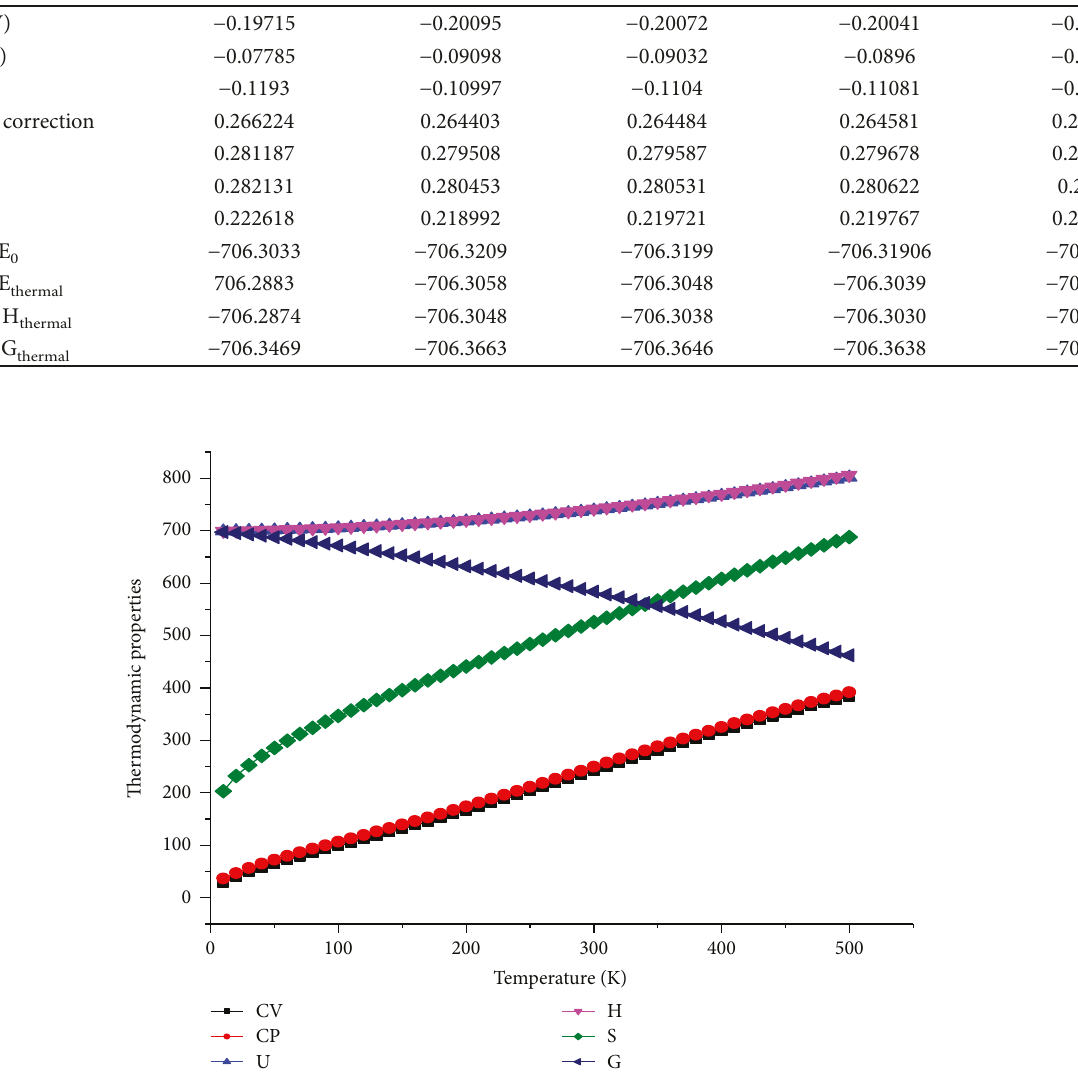
Table 6: Energy values along with some thermodynamic corrections at DFT/B3LYP/6-311G++ in di ff erent phases. Properties